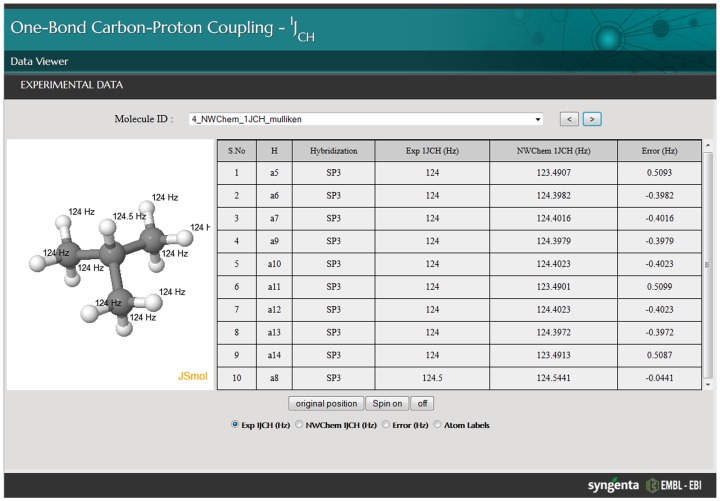
Screenshot of the Javascript application developed to visualise experimental and calculated 1JCH.